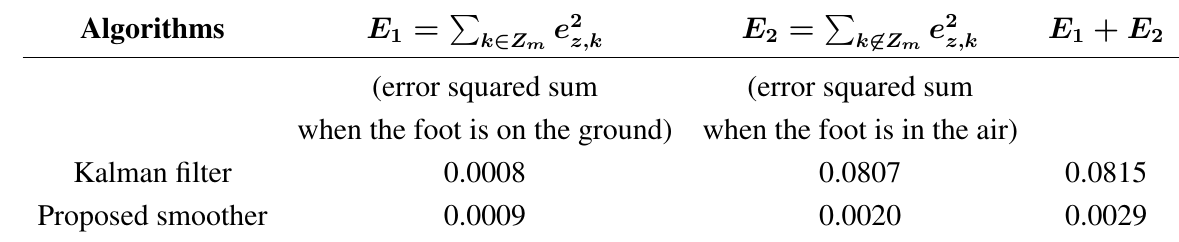
Table 2. Estimated z position error squared sum with the flat floor assumption.